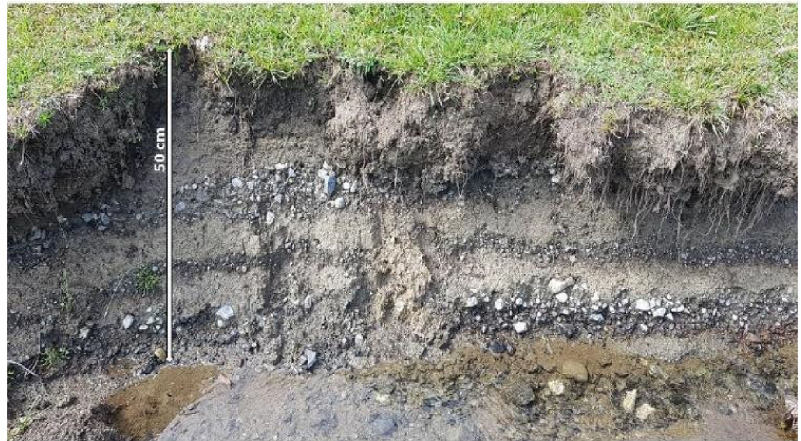
Figure 6. Representative photograph of the entrenched right side of the mainstream showing the uppermost 50-cm-thick sedimentary succession. Graded pebble–sand couplets are interpreted as a sheet-flood lobe deposit. Location in Figure 7.